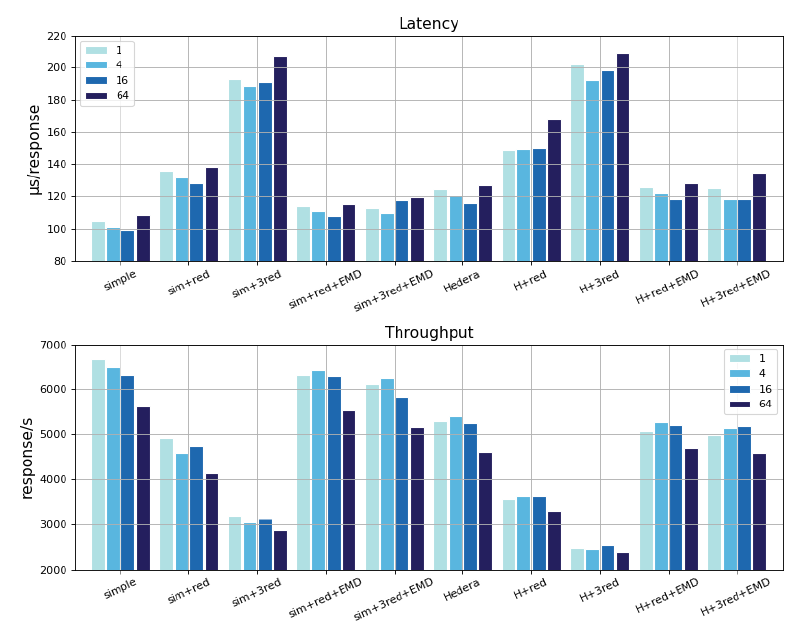
Figure 7. Latency & Throughput Test of Ryu under Various App